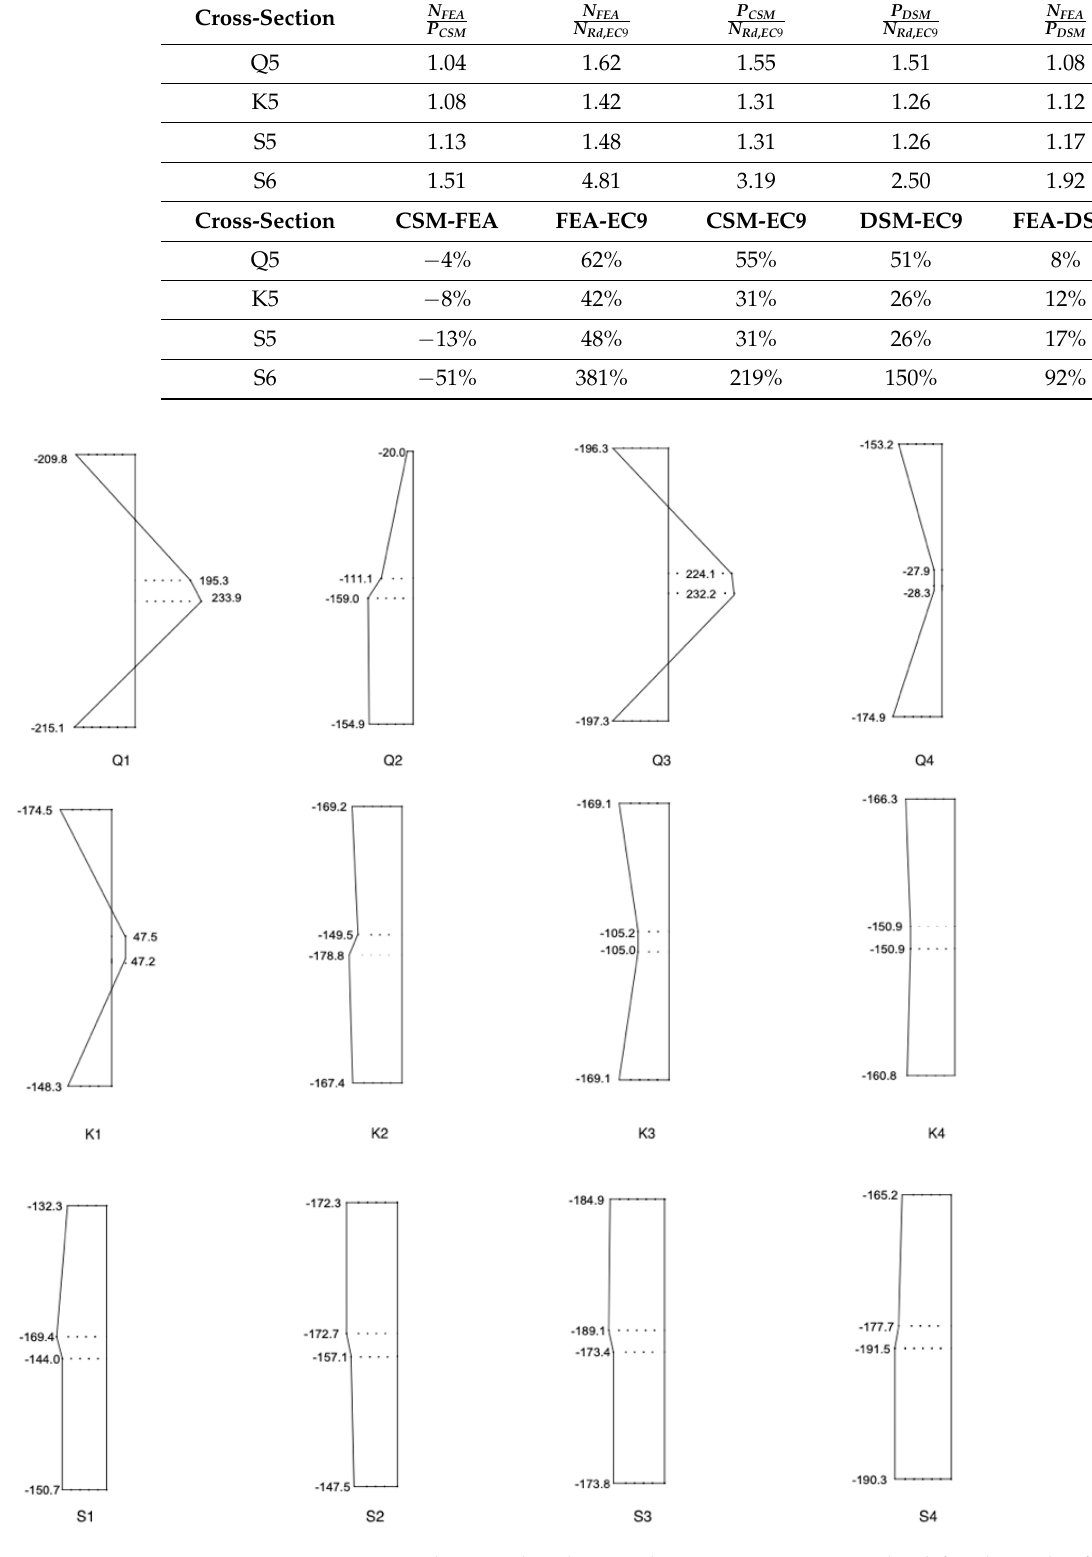
Figure A1. Cross-sectional stress distribution diagrams at maximum load for the web of each column type.